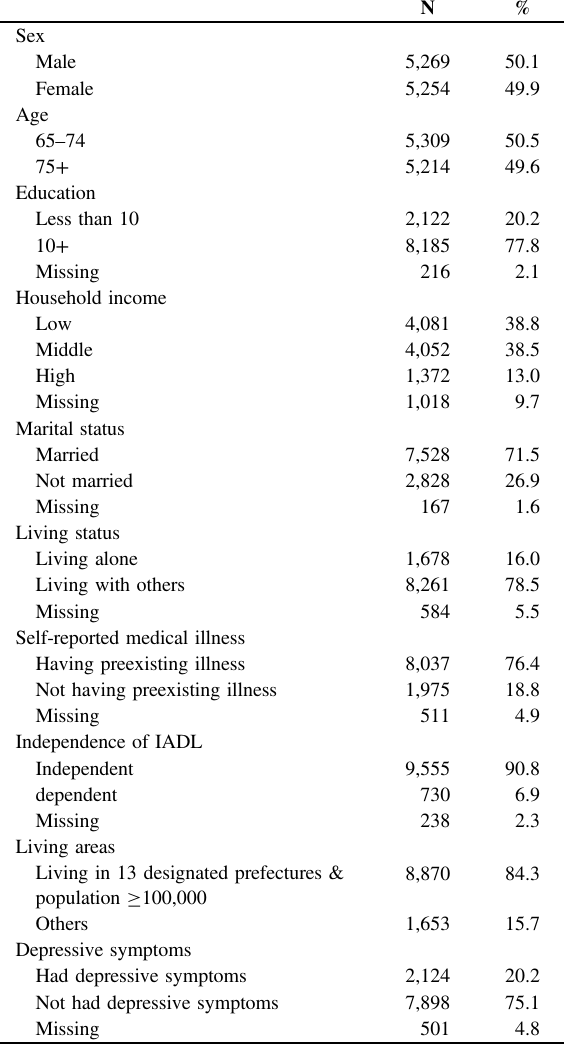
Table 1 Characteristics of participants (n = 10,523)